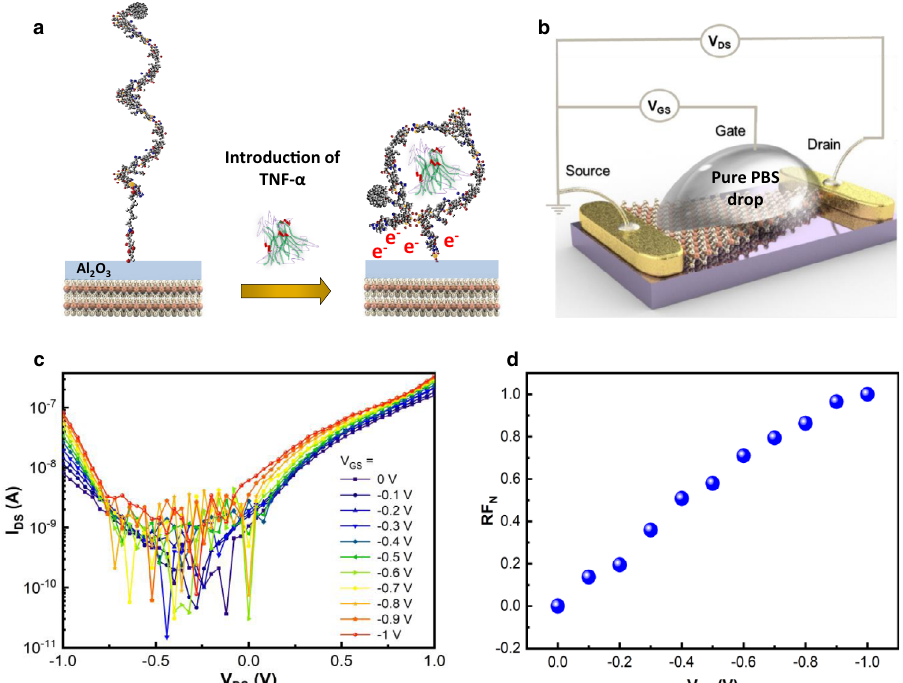
Fig. 4 | Detection mechanism. a Illustration of the folding of an aptamer, forming a compact G-quadruplex structure, due to the interaction of the TNF- α cytokine and aptamer, which brings negative charges closer to the Al 2 O 3 thin fi lm coated sensor surface. b Schematic diagram of a setup to support the proposed detection mechanism by investigating the effect of